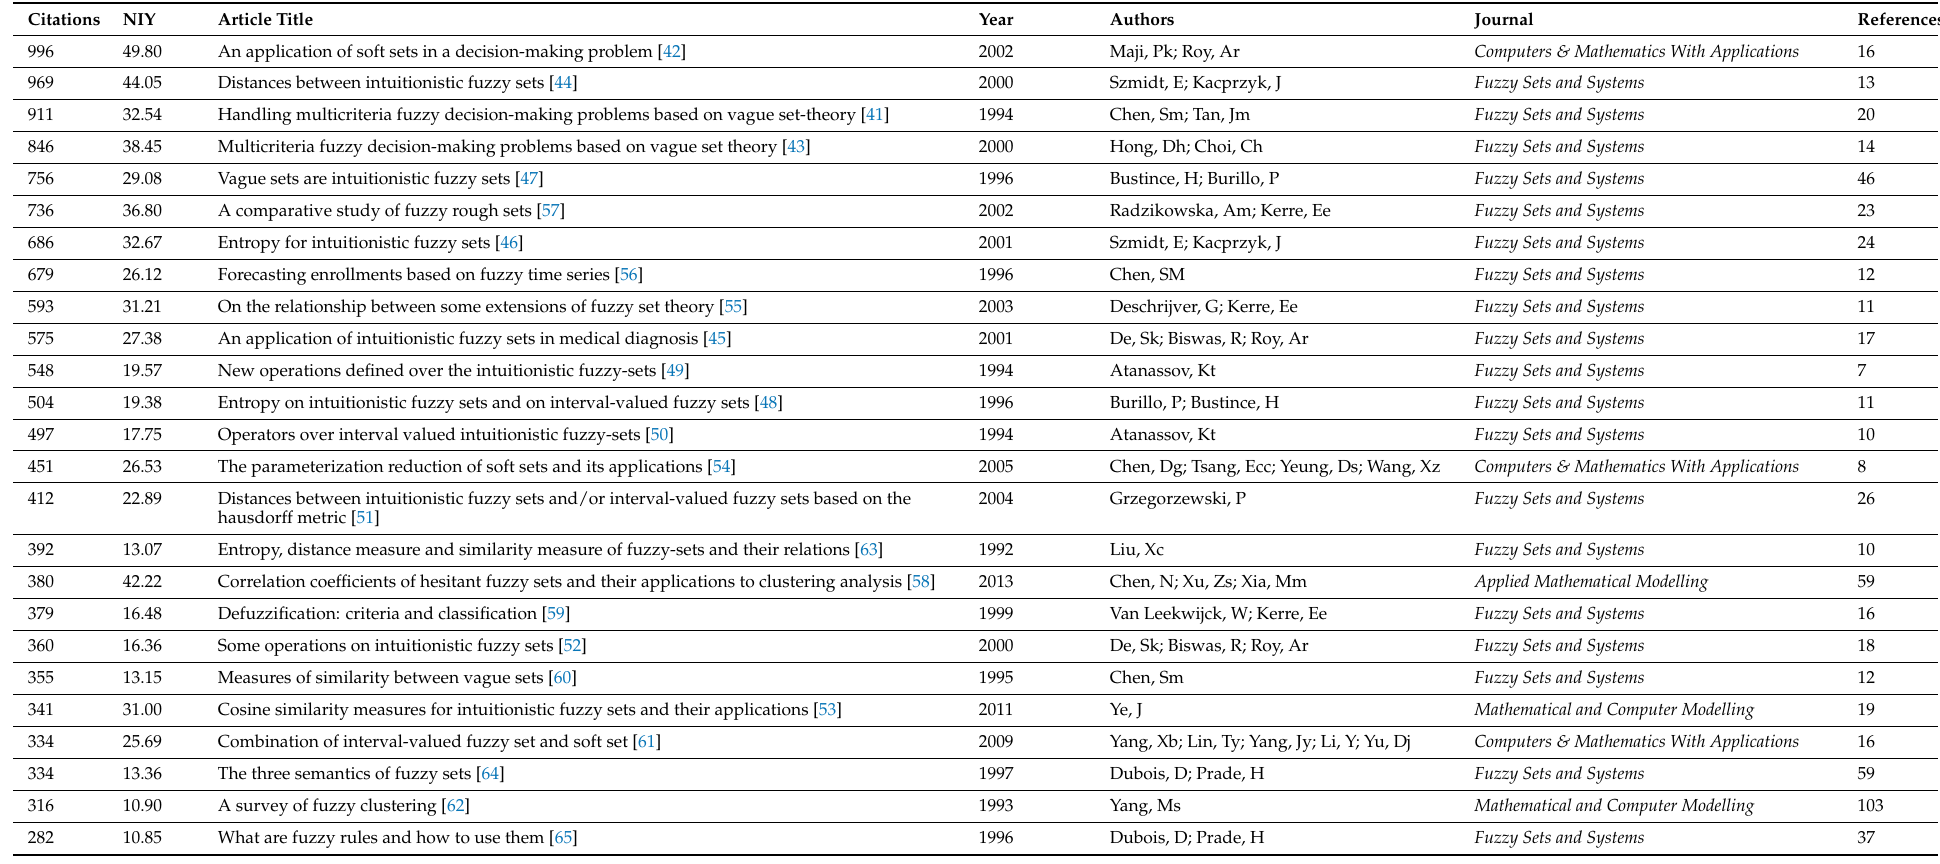
Table A1. Higher-impact articles for a wide scope and research